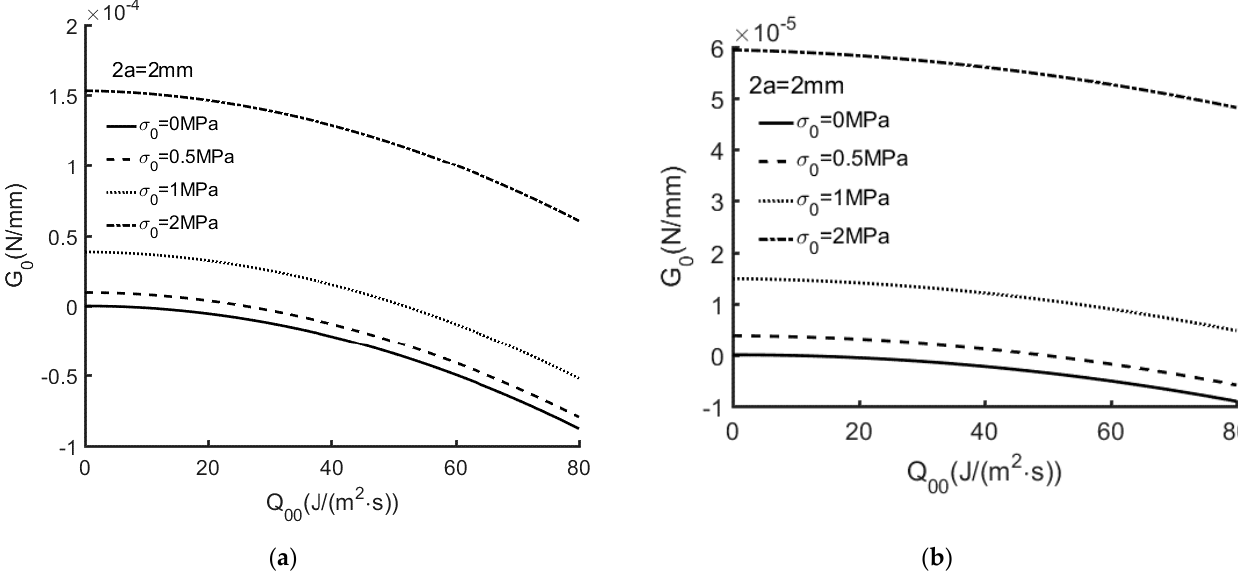
Figure 7. ( a ) G 0 versus tension stress with σ 0 = 0, 0.5, 1, 2 MPa for E c = 0, ε = 0. (2a = 2 mm). The orthotropic material listed in Table 1. ( b ) G 0 versus tension stress with σ 0 = 0, 0.5, 1, 2 MPa for E c = 0, ε = 0. (2a = 2 mm). The isotropic material listed in Table 2.